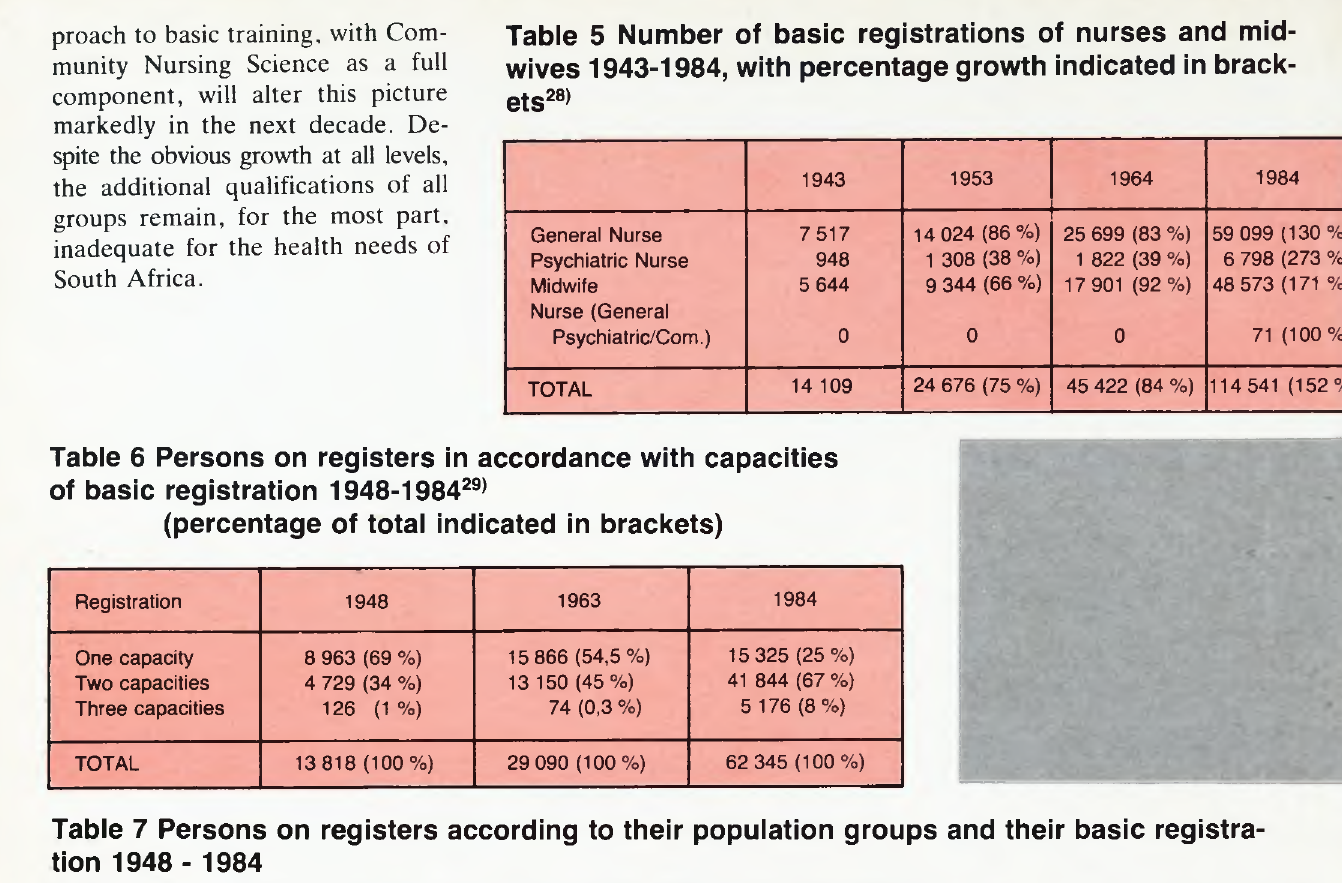
Table 7 Persons on registers according to their population groups and their basic registra­